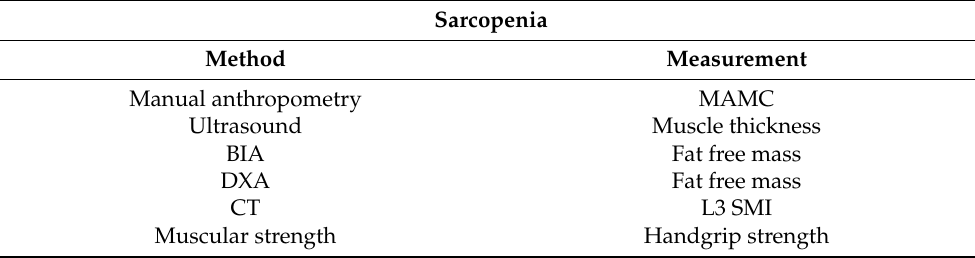
Table 2. Main methods and measurements to assess